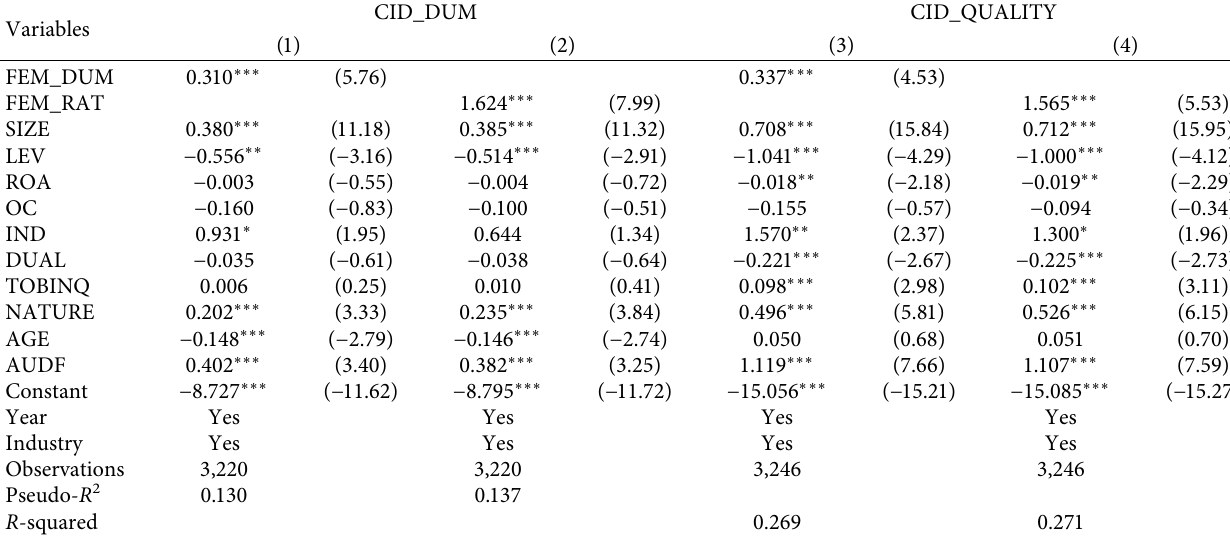
Table 8: Regression results of Hypothesis 1.